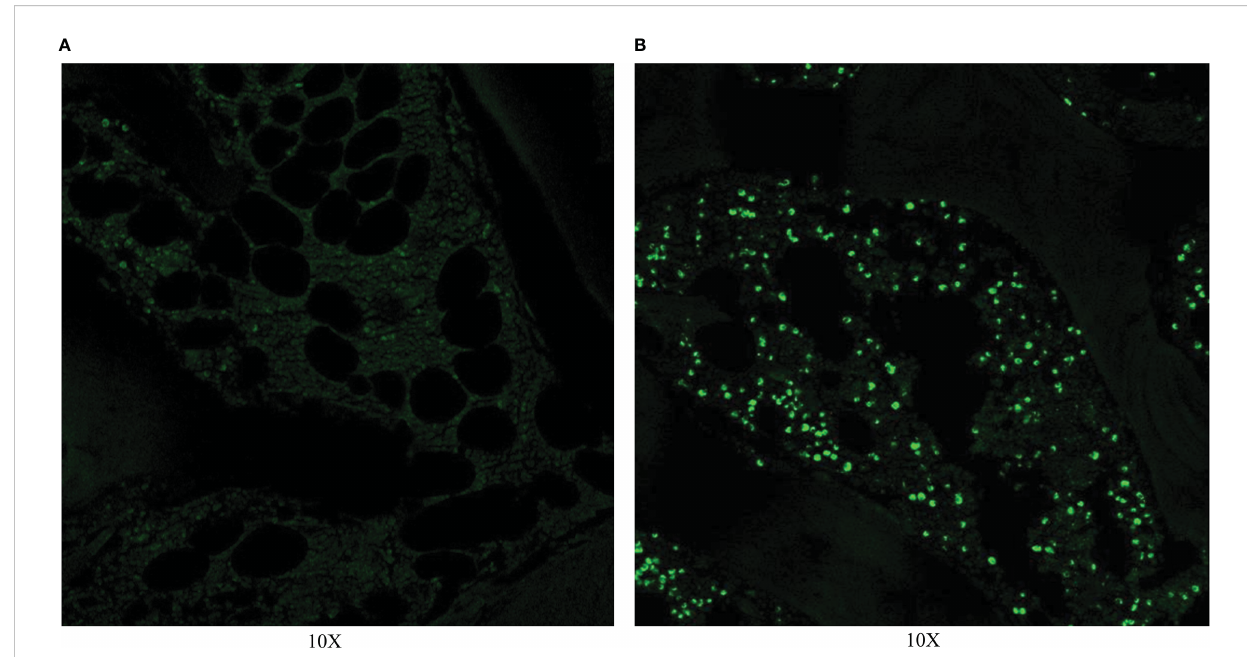
FIGURE 4 TUNEL on day 0. (A) TUNEL showed no apoptotic cell in normal vertebra. (B) TUNEL showed a large number of apoptotic cells in the ablation zone.